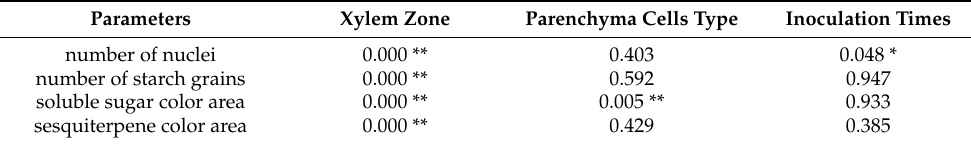
Table 1. One-way ANOVA results ( p ) of xylem structure with xylem zone, parenchyma cell types, and inoculation